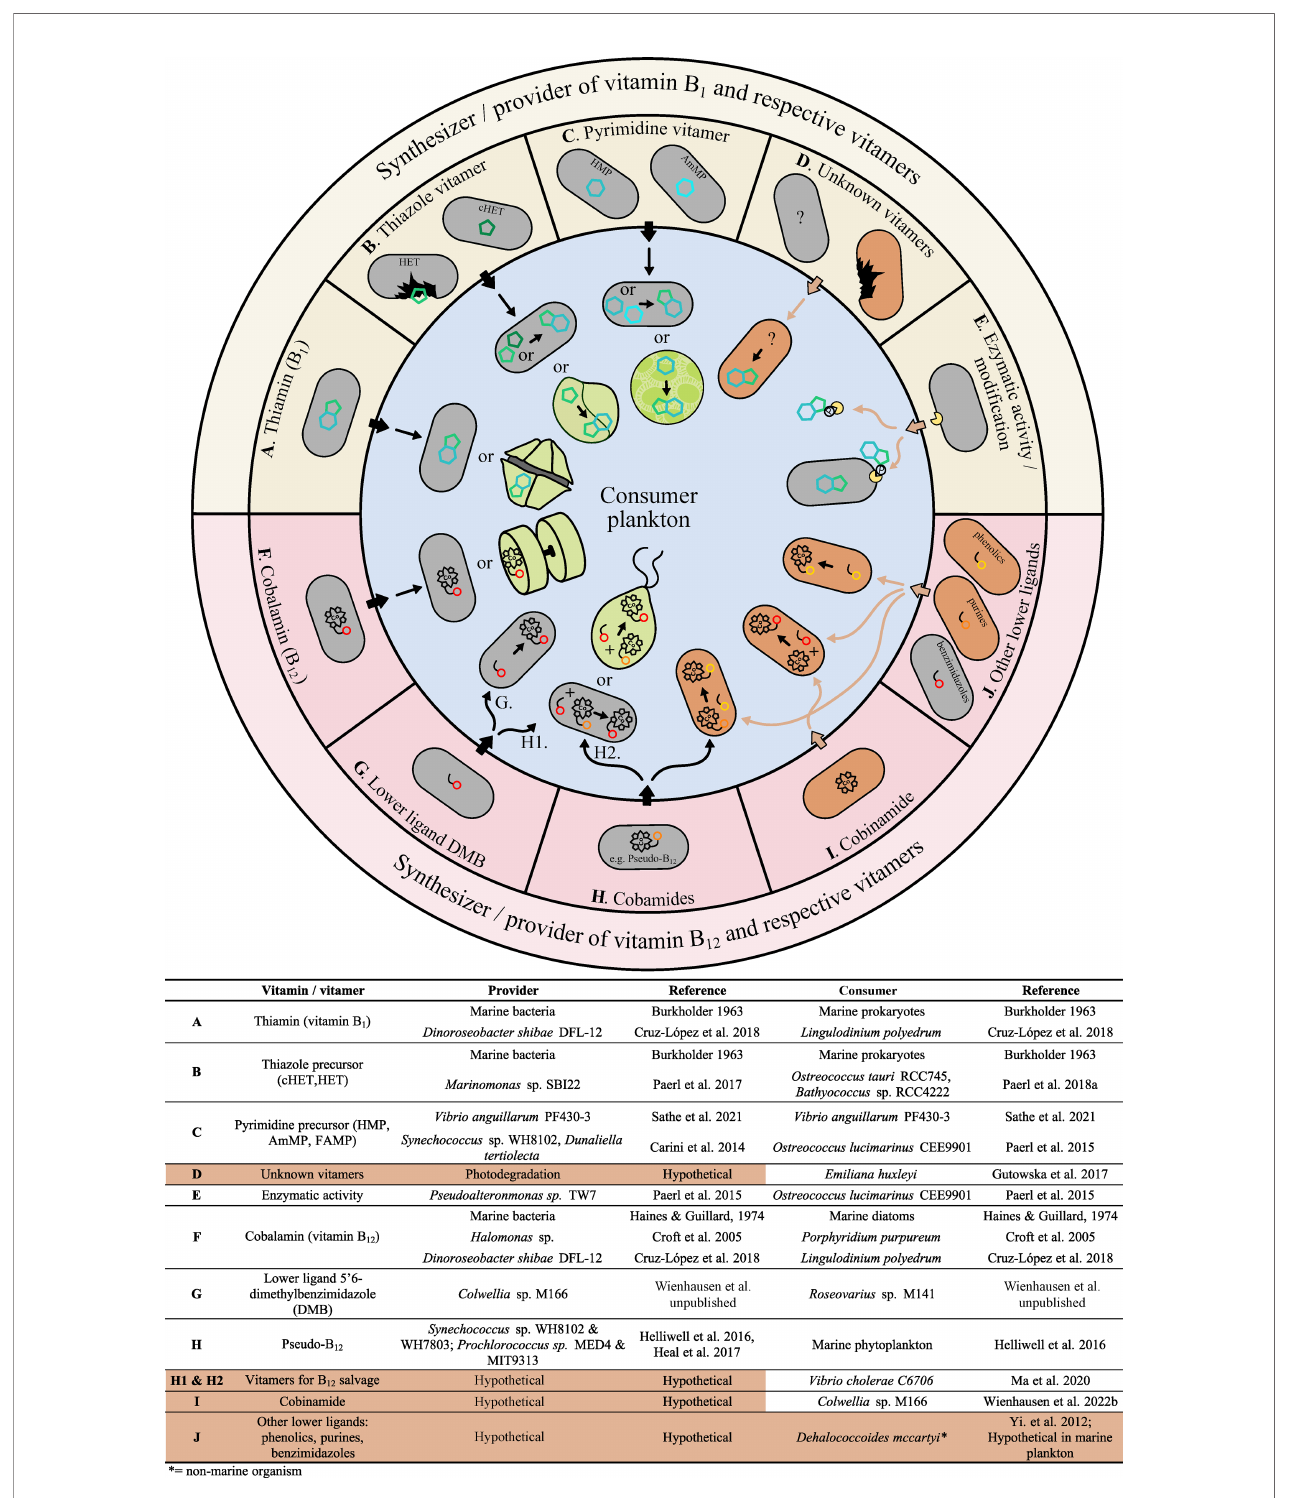
FIGURE 1 | B-vitamin/vitamer exchange amongst marine plankton. The outer ring illustrates prokaryotes that synthesize and provide vitamins or vitamers. Examples of vitamin B 1 and respective vitamers (A – E) are shown in the yellow semicircle and examples of vitamin B 12 and respective vitamers (F – J) are shown in the red semicircle. The inner blue circle shows prokaryotic and eukaryotic plankton recipients that can use vitamin B 1 and respective vitamers (A – E) or vitamin B 12 and respective vitamers (F – J) . Details on (A – J) , including citations and representative organisms displaying each trait, are provided in the bottom grid. Provider and consumer microbial traits that are hypothetical or have not yet been veri fi ed in the marine environment are highlighted in orange and noted